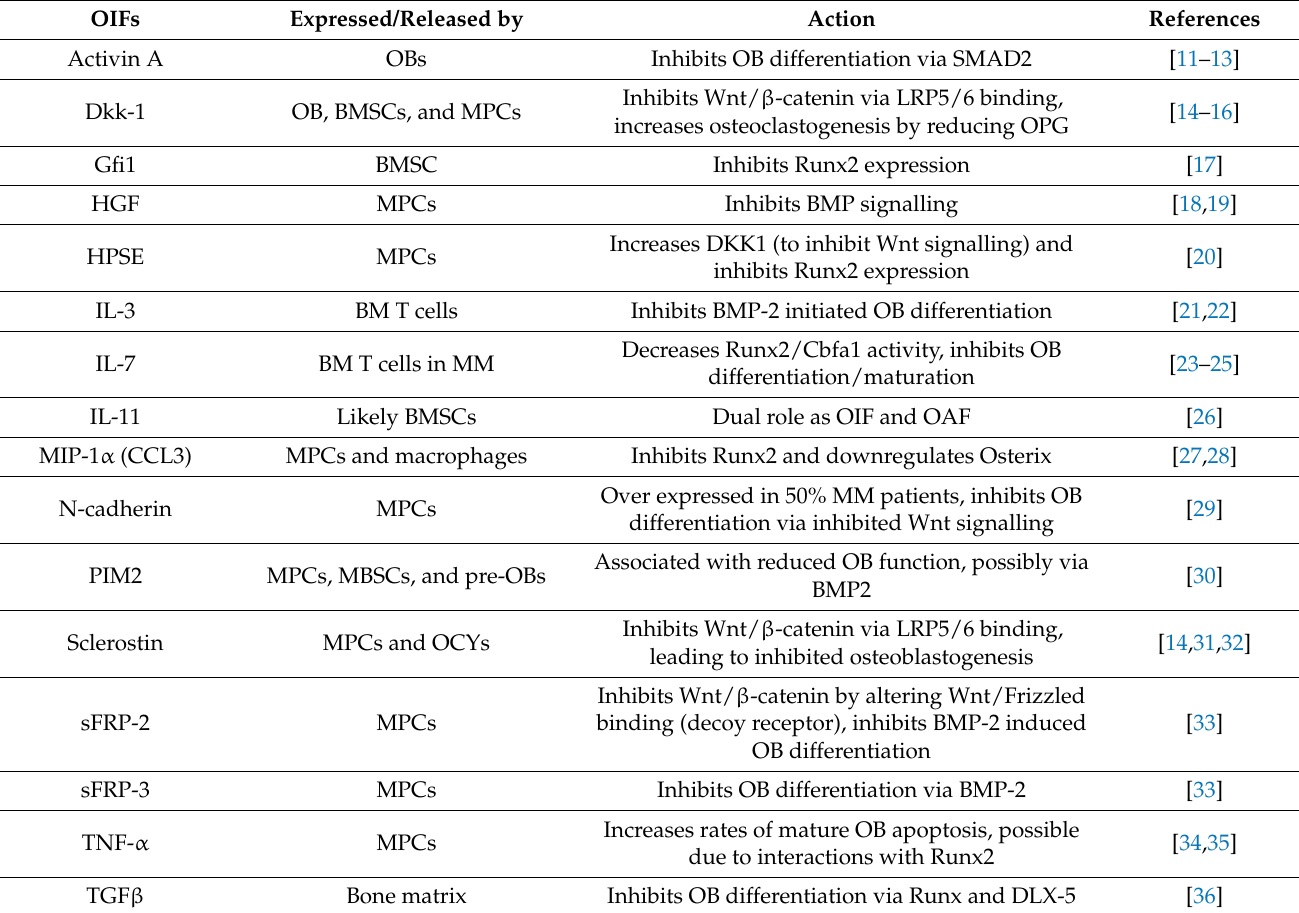
Table 1. Summary of osteoblast inhibiting